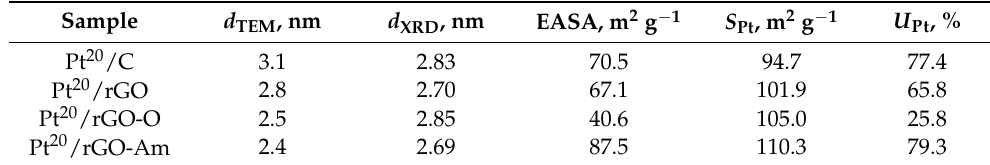
Figure 2. X-ray diffraction patterns for Pt 20 /C, Pt 20 /rGO, Pt 20 /rGO-O and Pt 20 /rGO-Am. Table 1. Comparative parameters of the obtained